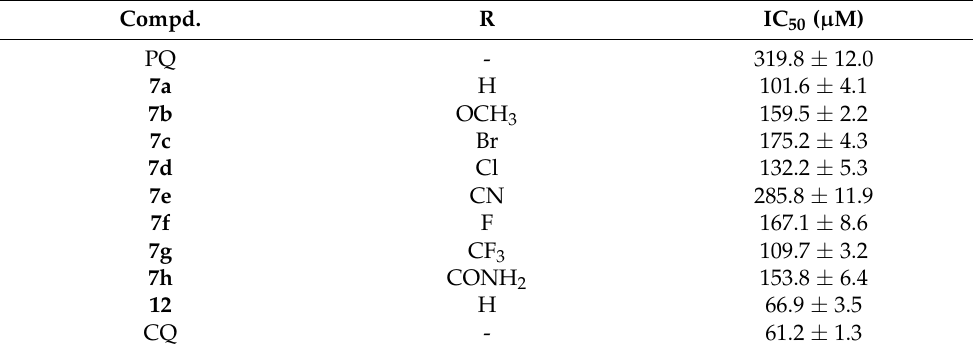
Table 2. Inhibition of hemozoin-initiated hematin polymerization at pH 5.0 1 .